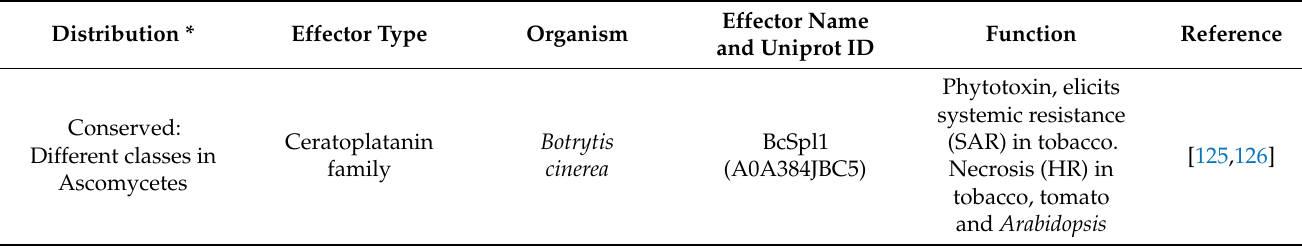
Table 1. Effectors can be species-specific, genus-specific or conserved across various